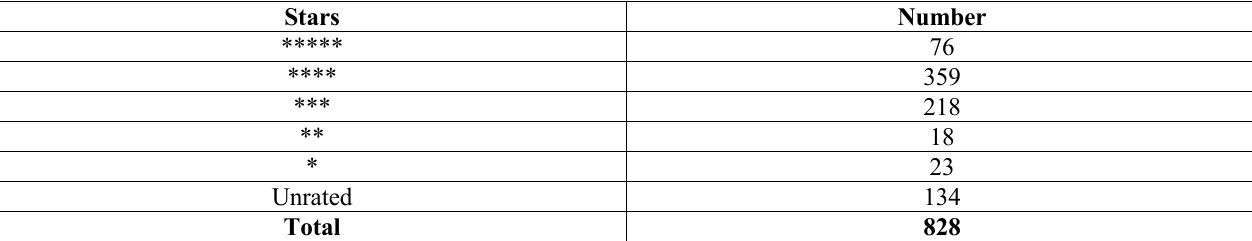
Table 4. Halal concept hotels in Italy, according to the number of stars Source: Authors’